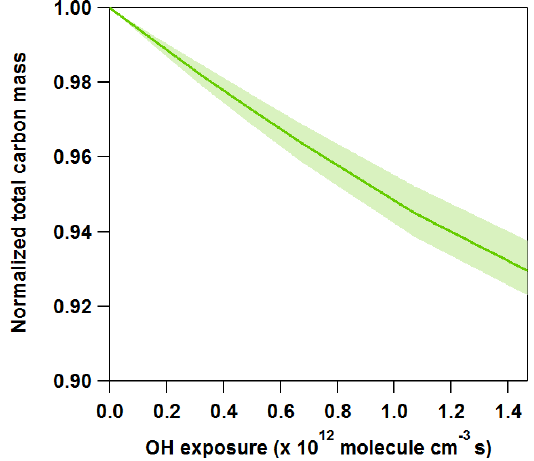
Figure 6. Simulated normalized total carbon mass during heteroge- neous OH oxidation of aqueous methylsuccinic acid droplet at 85% RH. The shaded region shows the error of the effective OH uptake coefficient ( γ eff ) measurement in the model